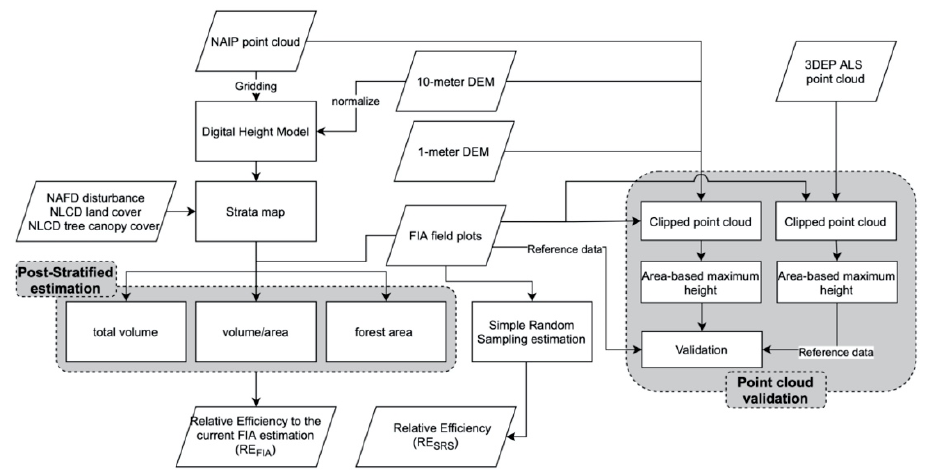
Figure 1. The workflow used to validate the NAIP point clouds and assess the NAIP digital height model (DHM)/canopy height models (CHMs) ability to post-stratify the FIA estimates.